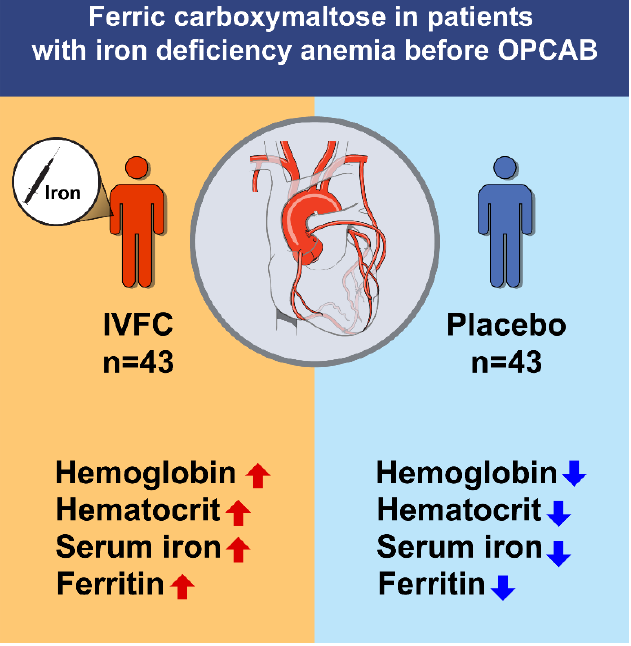
Figure 3. Infographic: Preoperative iron administration improved the postoperative recovery of hematologic parameters.